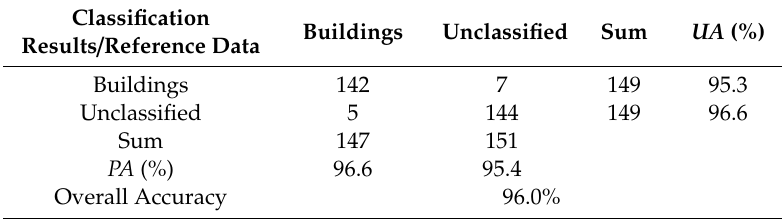
Table 2. Error matrix for the GEOBIA analysis in 2001 ( PA : producer accuracy; UA : user accuracy).